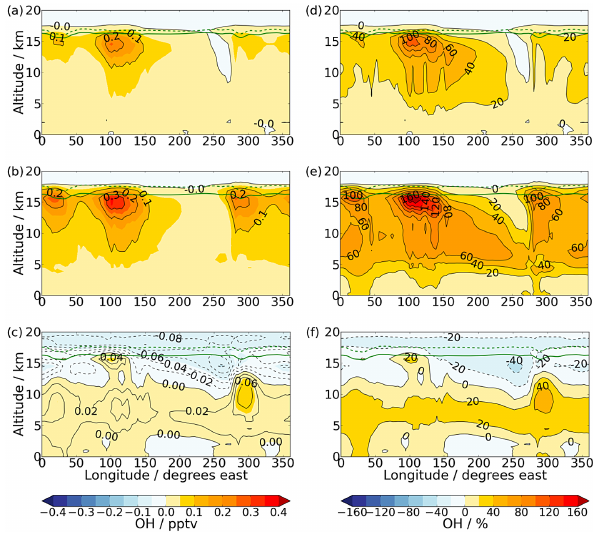
Figure 4. Annual mean, longitude–altitude cross sections of trop- ically averaged (20 ◦ S–20 ◦ N) changes (shading and contours) in OH volume mixing ratios (pptv) from Base to (a) 1 CC4.5 (b) 1 CC8.5 and (c) 1 CC8.5( f LNO x ) ; the differences as a percent- age of the Base values for (d) 1 CC4.5 (e) 1 CC8.5 and (f) 1 CC8.5( f LNO x ) . Solid (Base run) or dashed (future runs) green lines indicate the height of the thermal